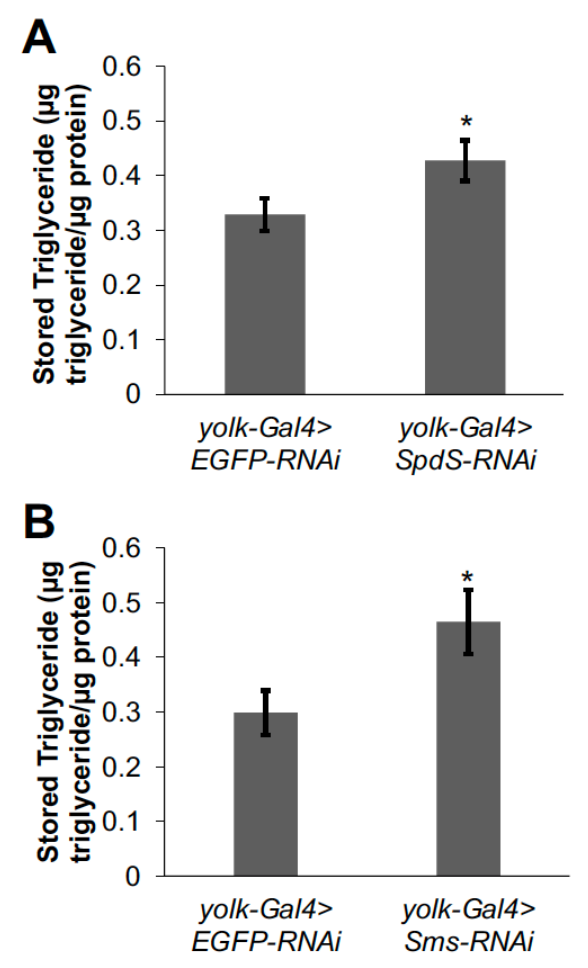
Figure 3. Decreasing either SpdS or Sms in the fat body increases triglyceride storage. Triglycerides were measured in ( A ) one-week-old female yolk-Gal4>SpdS-RNAi flies and yolk-Gal4>EGFP-RNAi controls ( n = 49–60) and ( B ) one-week-old female yolk-Gal4>Sms-RNAi flies and yolk-Gal4>EGFP-RNAi controls ( n = 19–20). Triglyceride measurements were normalized by dividing by total protein content. Bars represent means ± S.E. * p < 0.05 using Student’s t -test comparing yolk-Gal4>SpdS-RNAi or yolk-Gal4>Sms-RNAi flies to the appropriate yolk-Gal4>EGFP-RNAi controls.